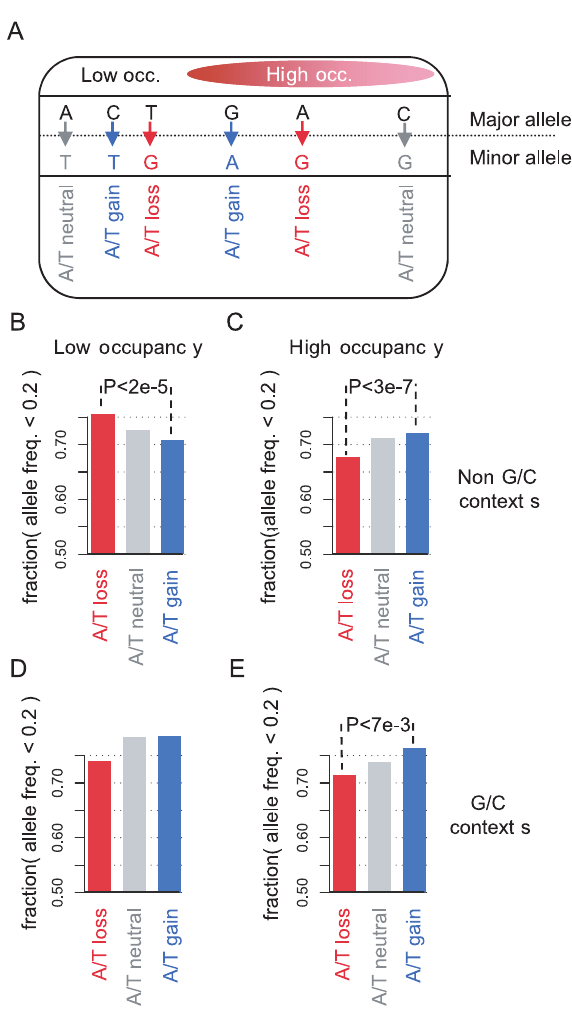
Figure 6. SNP data support the compensatory evolution hypothesis. Data [39] on allele frequencies in a sample of S. cerevisiae strains was used to test the hypotheses that low and high occupancy sequences maintain their local G + C content due to weak selection. Theory predicts that allele frequencies of deleterious mutations would tend to be smaller than frequencies of neutral mutations and that SNPs representing beneficial mutations would be frequently observed at higher allele frequencies. A ) Classifying SNPs. Major and minor alleles at SNPs representing postulated A/T gain and A/T loss at low and high occupancy loci were determined as illustrated. Loci with G/C flanking context were analyzed separately. B–E ) Allele frequencies. The groups of SNPs were compared by computing the fraction of SNPs with minor allele frequency smaller than 20%. Shown is the fraction of rare alleles in cases of A/T gain, A/T loss and A/T neutral polymorphisms in non G/C contexts in low occupancy sequences (B), non G/C contexts in high occupancy sequences (C), G/C contexts in low occupancy sequences (D), G/C contexts in high occupancy sequences (E). The data show A/T losing SNPs tend to be rarer than neutral SNPs and A/T gaining SNPs in low occupancy sequences. The opposite behavior is observed at high occupancy sequences or at G/C contexts, confirming the predictions of our evolutionary model.